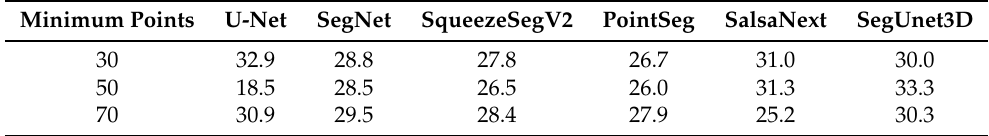
Table 4. Results of different segment size on RELLIS-3D. The values are in %. Minimum